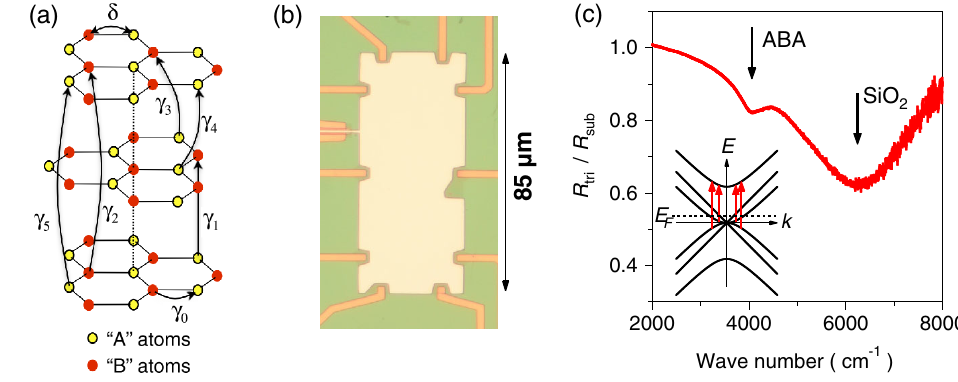
FIG. 1. (a) Crystal structure of ABA (Bernal)-stacked trilayer graphene. Arrows indicate the tight-binding hopping parameters of the Slonczewski-Weiss-McClure model appropriate for trilayer graphene [8,9]. (b) Optical image of a 3000 - (cid:1) m 2 dual-gated ABA-stacked trilayer field-effect device. (c) Infrared reflectance, R tri , of the trilayer flake shown in (b), normalized to the substrate reflectance, R sub . The dip near 4000 cm (cid:1) 1 is due to transitions to or from the split-off bands, as shown schematically in the inset to (c) for the case of light electron doping. The larger dip at 6000 cm (cid:1) 1 is due to interference in the thin SiO 2 layer